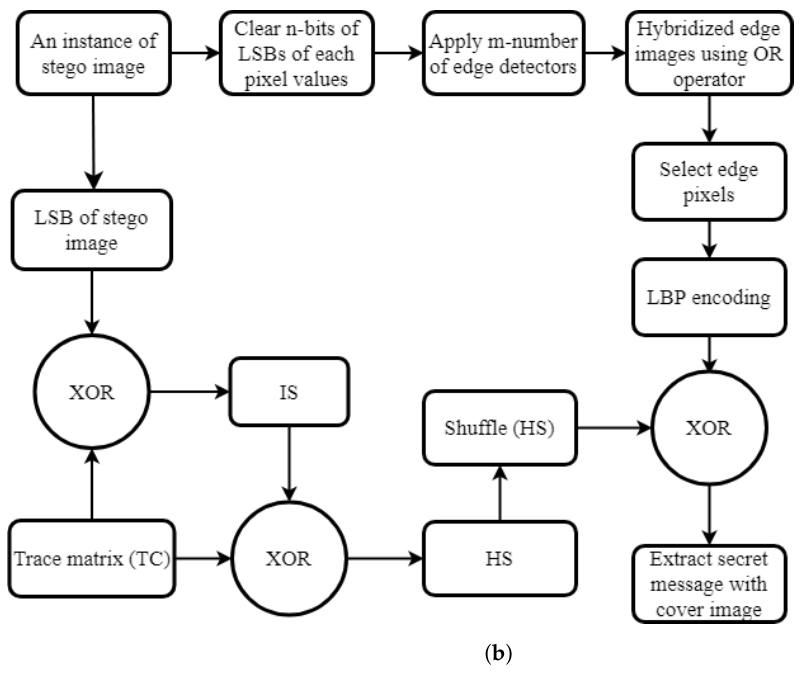
Figure 2. Proposed method scheme. ( a ) Embedding process; ( b ) Extraction